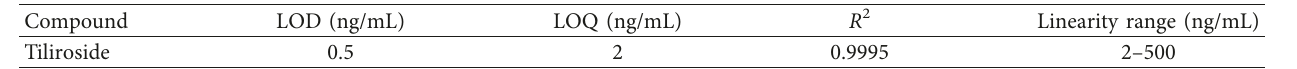
Table 3: Analytical parameters of LC-MS/MS quantitative method.